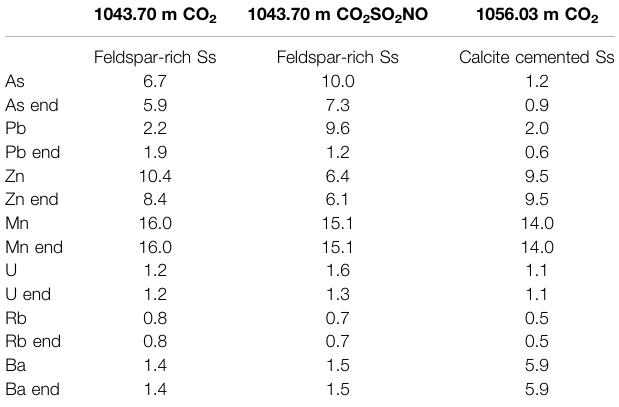
TABLE 6 | Selected elements released from the core samples with CO 2 or CO 2 SO 2 NOreaction,reportedasapercentageofthetotalamountavailablein the core. The percentages are calculated by mass balance using the maximum released concentrationaftergasaddition and,separately,theconcentrationatthe end of the experiment (denoted “ end ” ). 1043.70 m CO 2